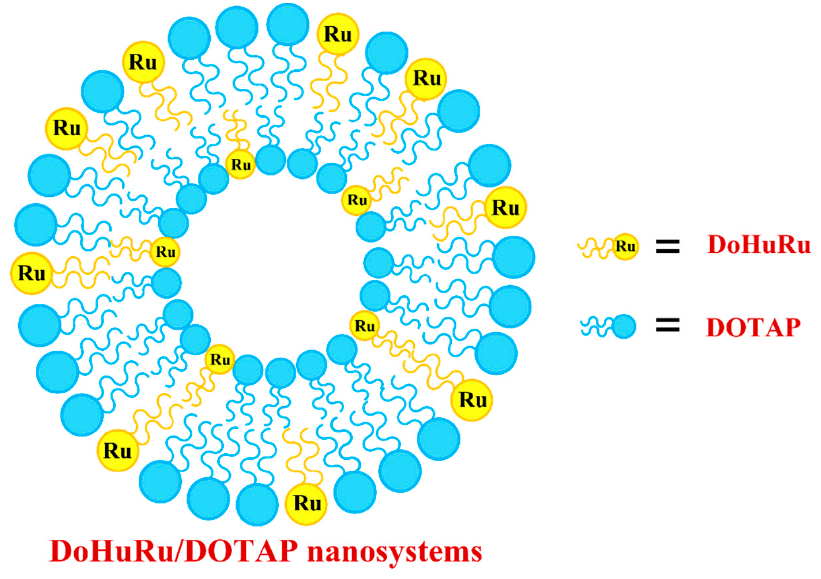
Scheme 2. Schematic representation of liposomal DOTAP-based nanoaggregates containing the nucleolipid-based Ru(III) complex